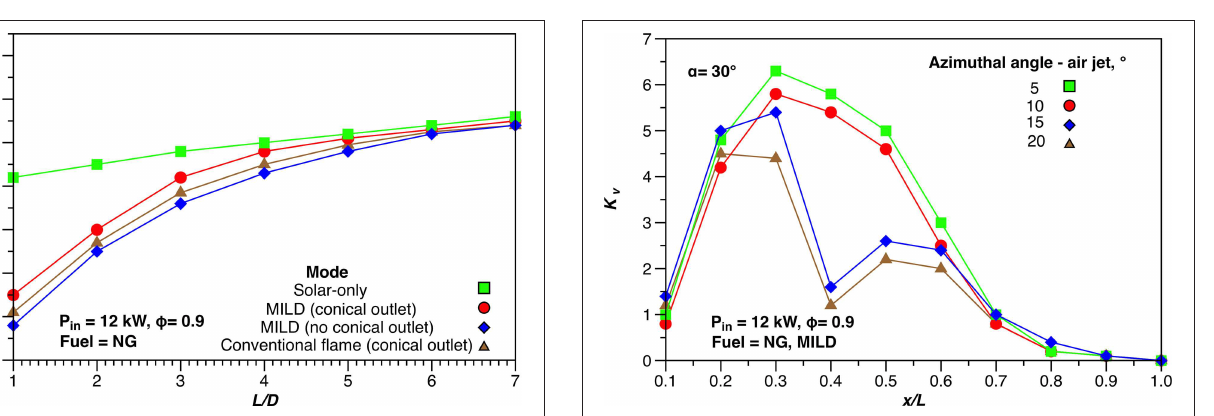
FIGURE 3 | Calculated values of the thermal efficiency, η th , as a function of the length-to-diameter cavity ratio, L/D , by varying the shape of the outlet section, mode of operation and combustion type (MILD vs. conventional).